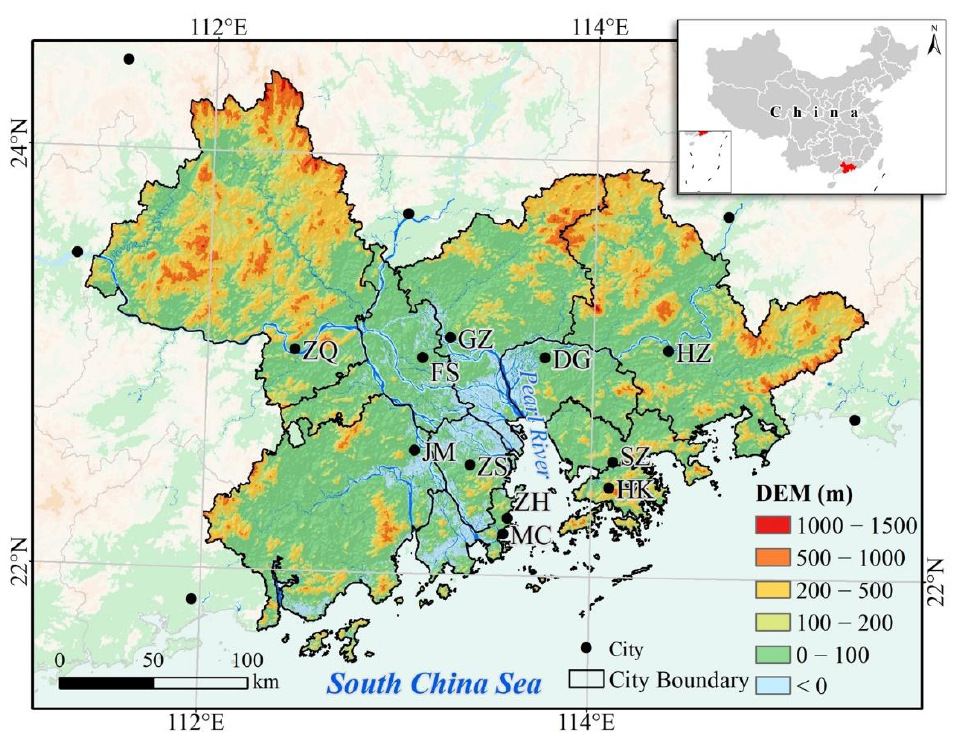
Figure 1. Location of the Greater Bay Area (GBA): from top to bottom, from left to right, cities are Hezhou (HZ), Wuzhou (WZ), Yangjiang (YJ), Zhaoqing (ZQ), Qingyuan (QY), Guangzhou (GZ), Foshan (FS), Jiangmen (JM), Zhongshan (ZS), Zhuhai (ZH), Macao (MC), Dongguan (DG), Shenzhen (SZ), Hong Kong (HK), Huizhou (HZ), Heyuan (HY), Shanwei (SW).